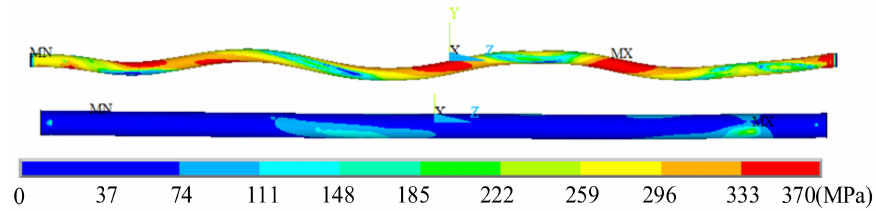
Figure 22. Stress distribution in ultimate bearing state.